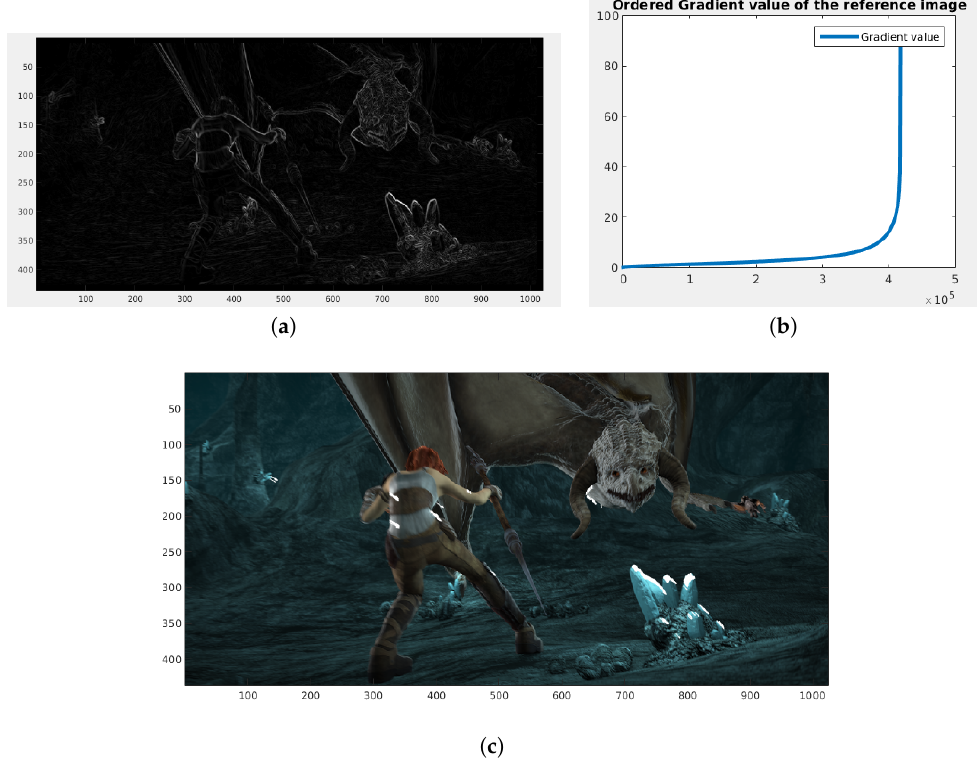
Figure 4. Correspondence of patches located in the largest magnitude of the gradient. ( a ) Gradient magnitude of the reference image. ( b ) Ordered gradient from the minimum magnitude to the maximum magnitude. ( c ) Correspondences of the patches located in the maximum gradient magnitudes (white